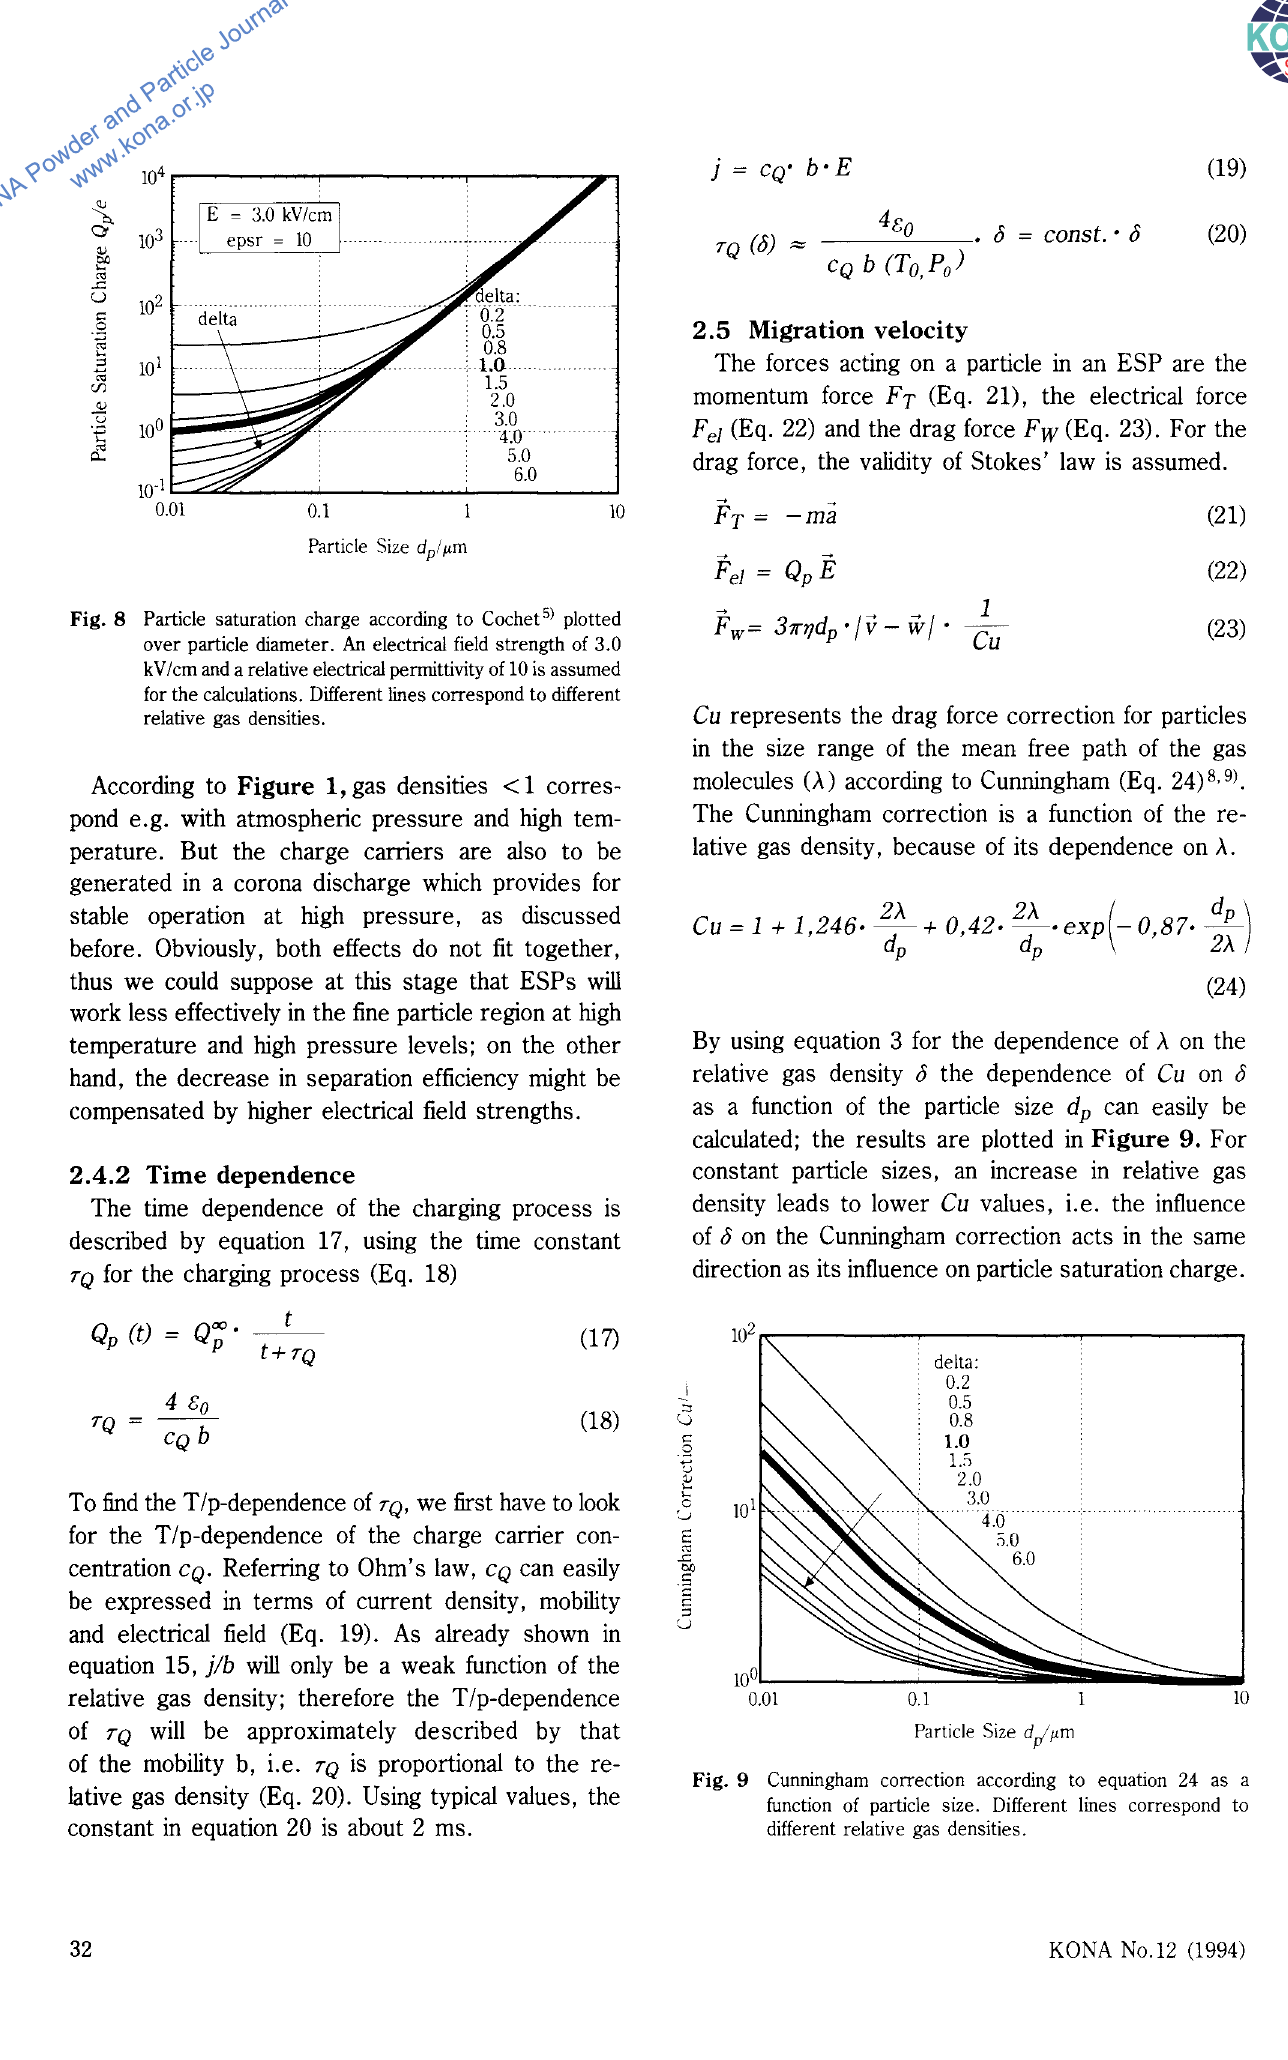
Fig. 9 Cunningham correction according to equation 24 as a function of particle size. Different lines correspond to different relative gas